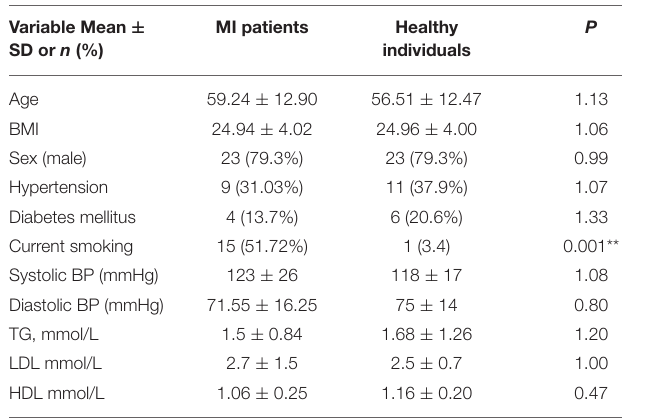
TABLE 1 | Participant characteristics.